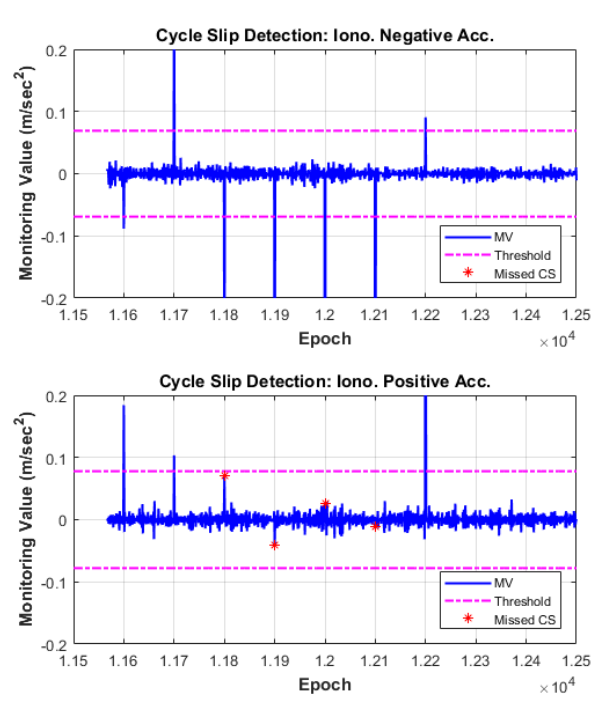
Figure 11. Cycle-slip detection results for G19.